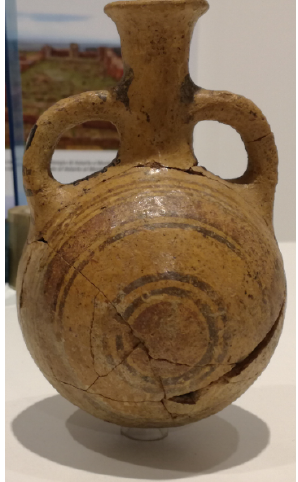
Figure 2: The Cipriot-Phoenician globular jug (IX-VIII century B.C.) used to test the 3D modelling capabilities of the Structure Sensor.